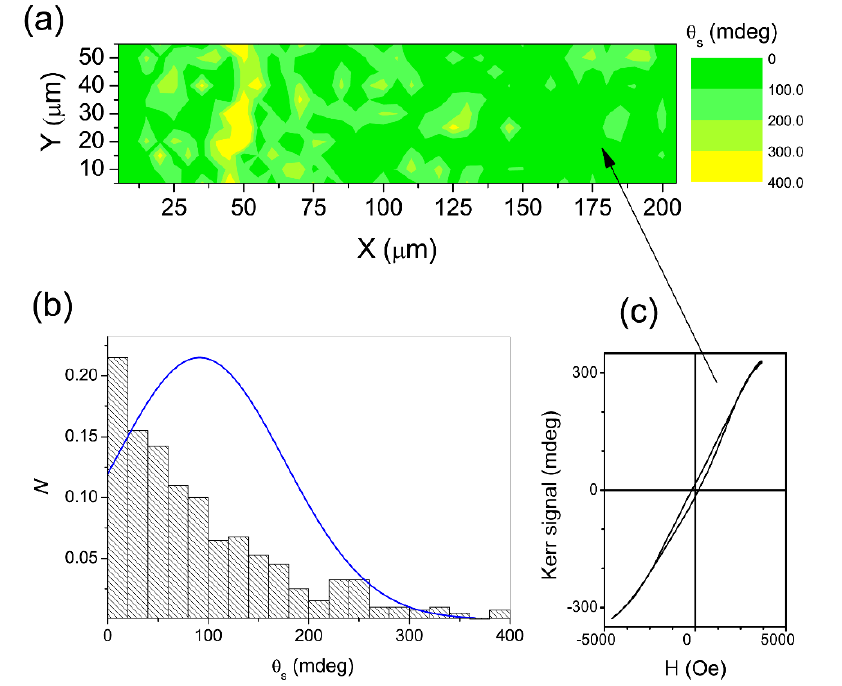
Figure 11. ( a ) Map of the Kerr rotation values at saturation. ( b ) Histogram representing the density of the sampled cells for a unit bin interval with a normal distribution fit (blue line) to the data. ( c ) Kerr hysteresis loop of the microzone (5 × 5 μ m 2 ) is indicated on the map by the arrow. Reproduced with permission from [101]. Copyright © 2022, EDP Sciences, Springer-Verlag GmbH Germany, part of Springer Nature Copyright 2019.